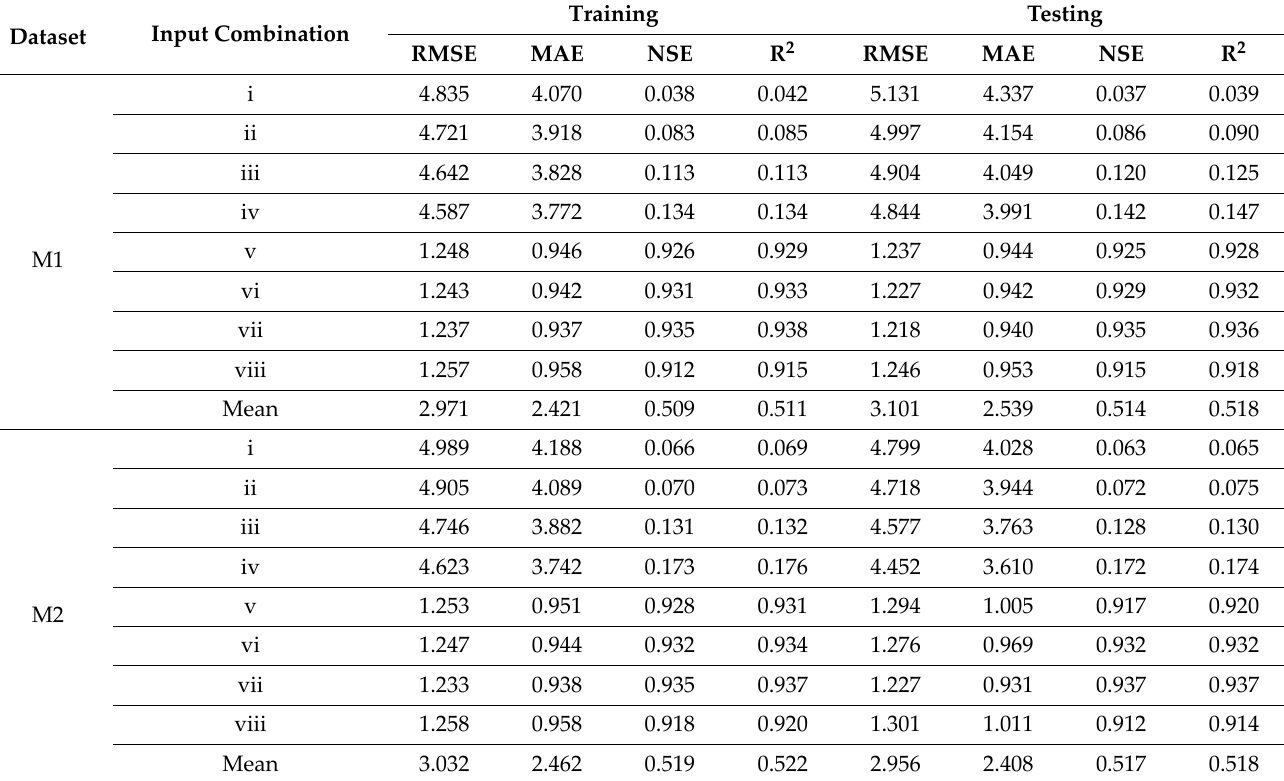
Table 8. The results of the model RVFL‑WCA for daily time